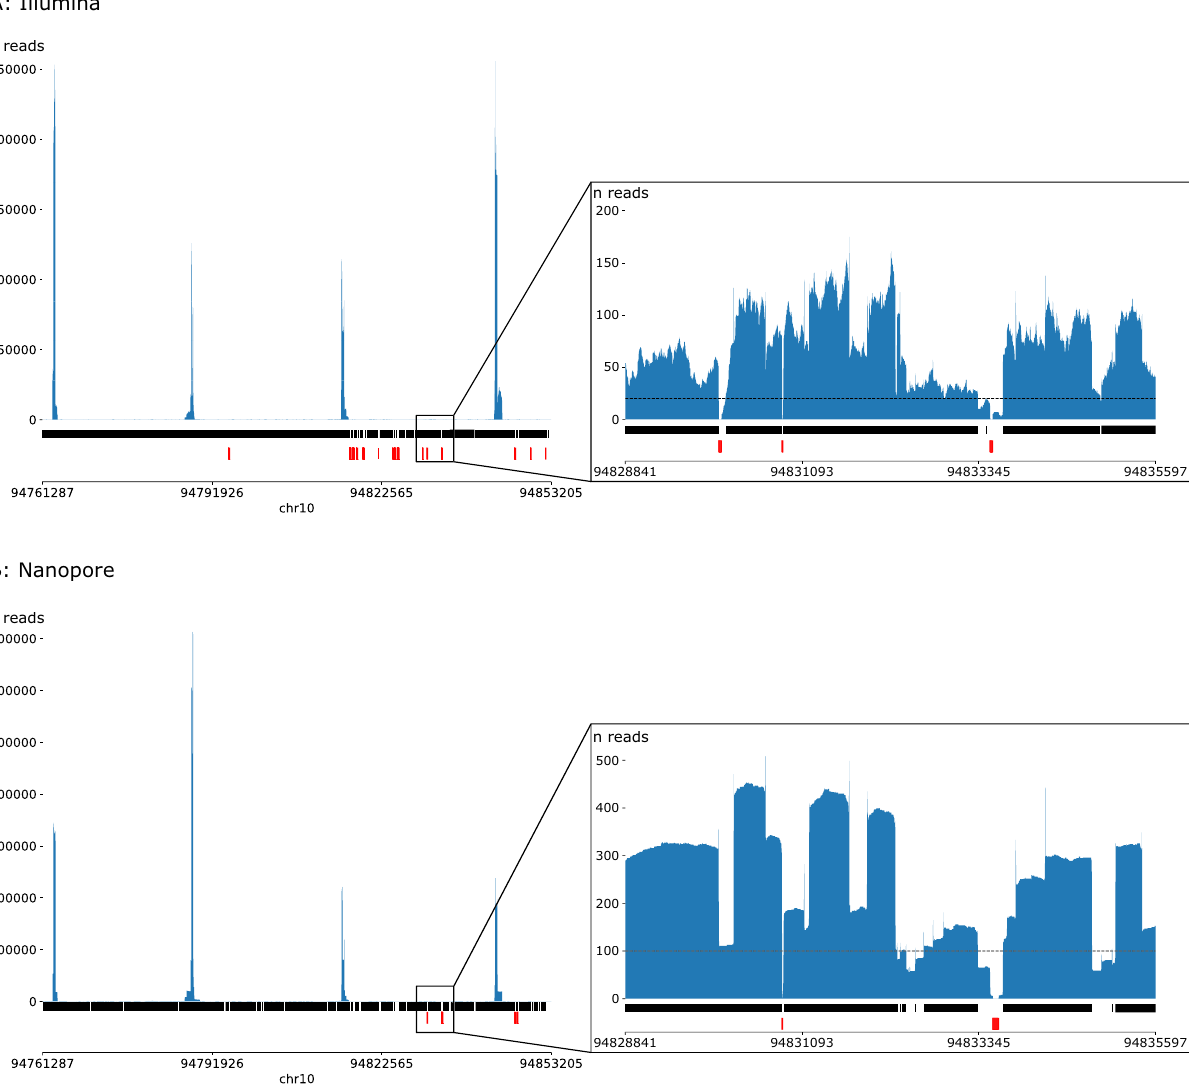
Figure 2. Coverage plots for CYP2C19 . ( A ) Illumina sequencing data; ( B ): Nanopore sequencing data. Blue surfaces represent the depth on each position in CYP2C19 ; dark bars under the graphs define the regions with a minimal depth, 25 reads for Illumina sequencing and 100 reads for Nanopore sequencing; red bars under the graphs represent regions with no